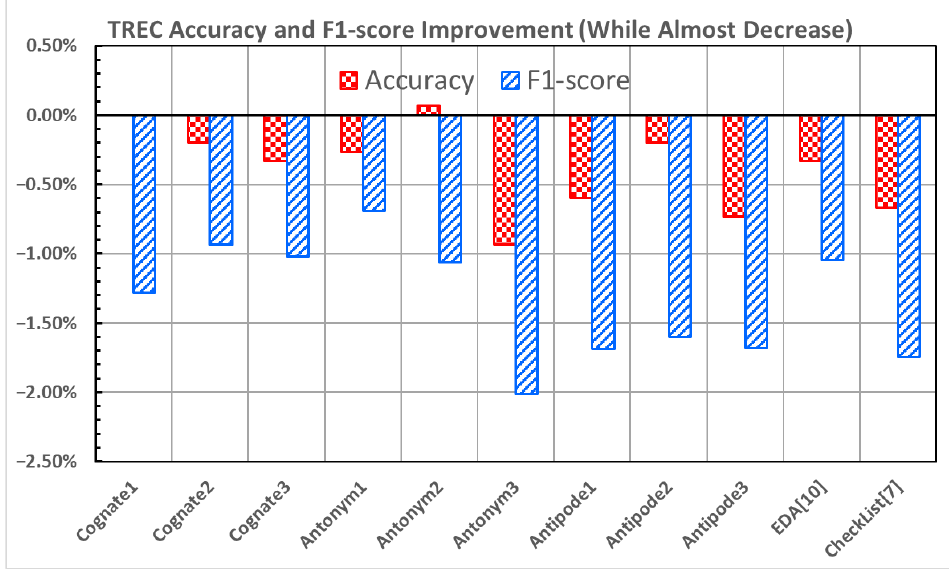
Figure 2. TREC Performance Improvement Results.